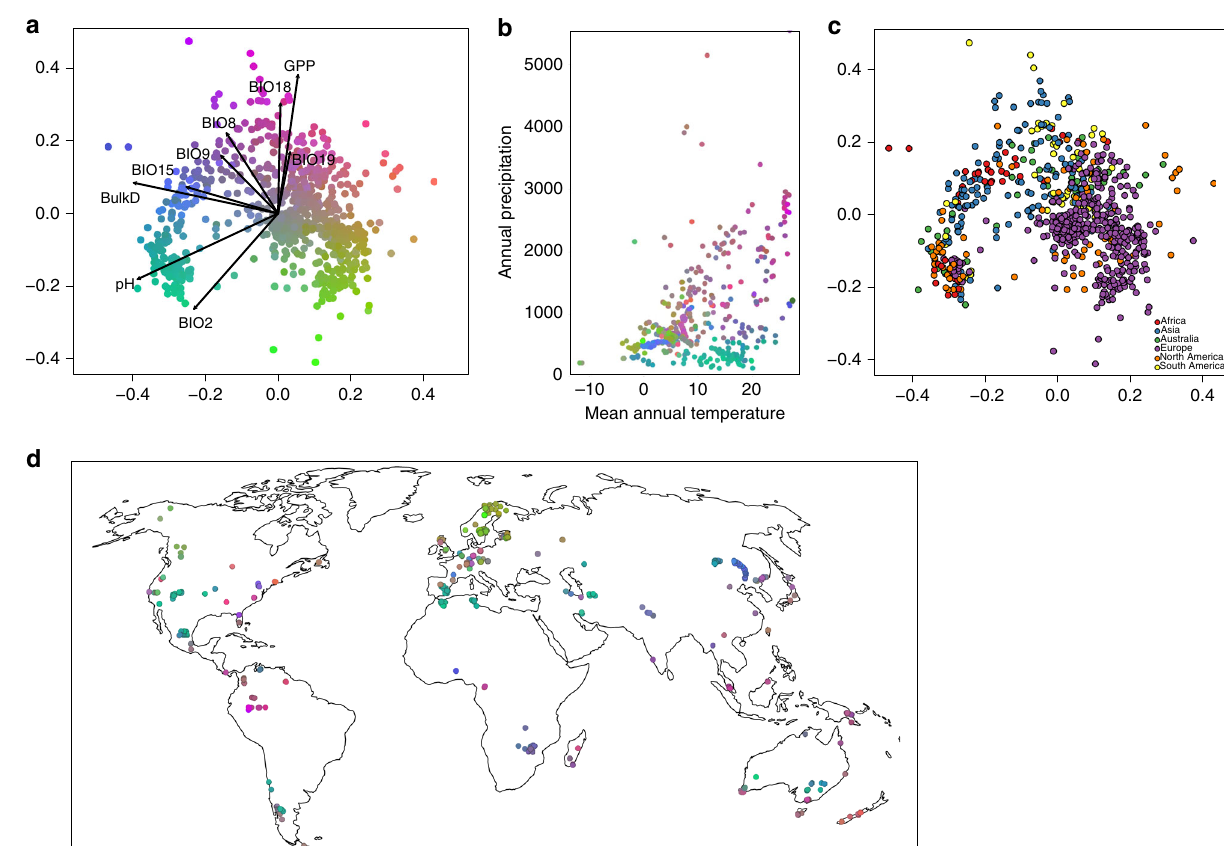
Fig. 4 Variation in community composition of fungal SH is driven by climate, but only weakly structured by dispersal. a Three-dimensional non-metric multidimensional scaling of fungal community composition based on Bray – Curtis dissimilarities (stress = 0.13). The fi gure shows the fi rst two ordination axes, but the third ordination axis is captured through the rgb colour coding of the samples. All environmental variables used in the random forest models are passively projected onto the ordination space. b Mean annual temperatures and annual precipitation of all analysed samples coloured as in panel ( a ). c The same ordination as in ( a ), but with samples coloured according to the continents, suggests relatively weak geographic patterns in the data. d Geographic distribution of the samples. The samples are coloured as in panel a; the more similar the colour is, the more similar the community composition of the